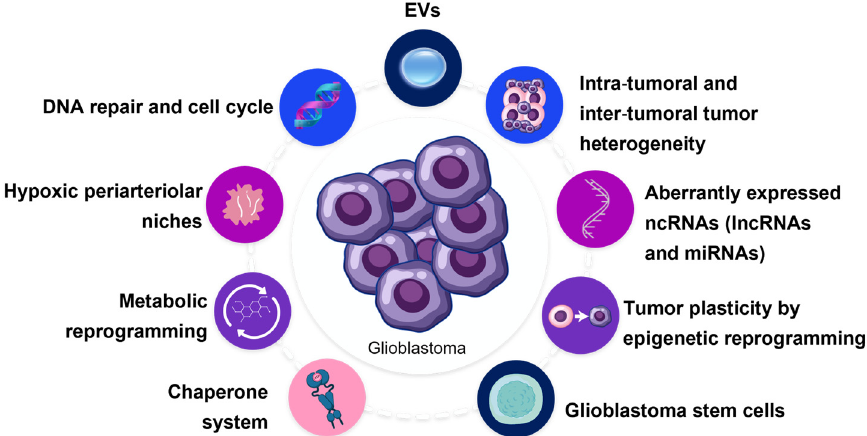
Figure 1. Schematic representation of factors and pathways involved in glioblastoma resistance to